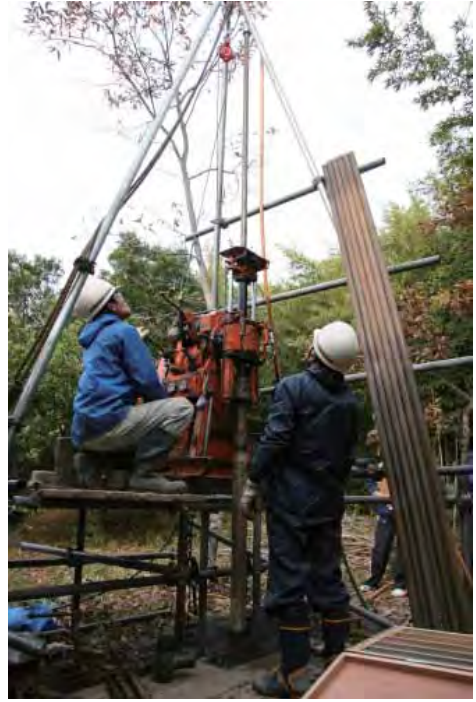
Figure 2. Core operations on a terrace in Tonohama, near type locality of Ananai